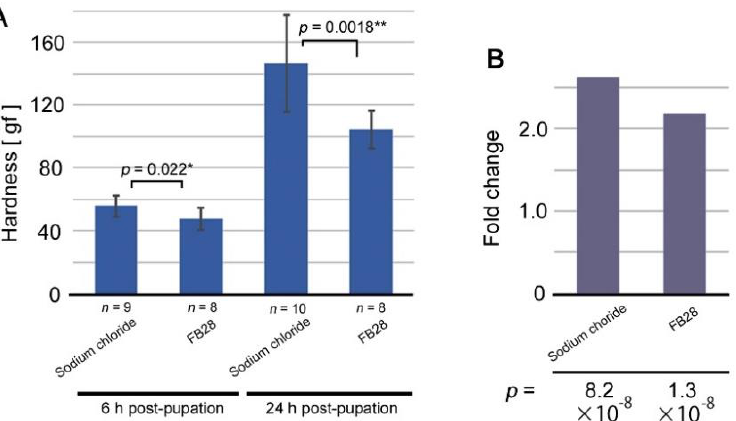
Figure 4. Results of mechanical load tests for pupae treated with FB28. ( A ) Pupal hardness 6 h and 24 h post-pupation. The hardness is expressed in gram-force. The number of treated pupae is shown for each treatment. Sodium chloride treatment was compared with FB28 treatment. Asterisks indicate